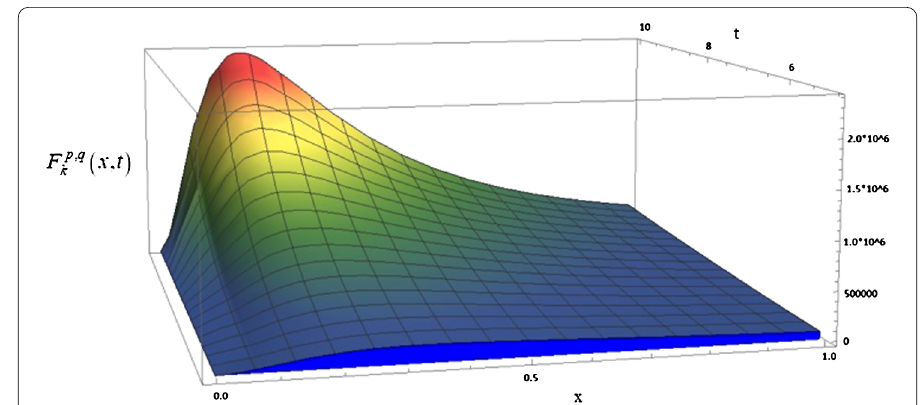
Figure 1 The generating function of ( p , q )-Bernstein